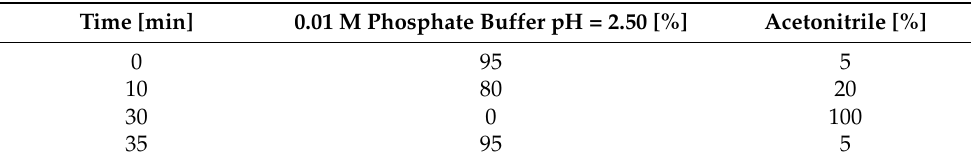
Table 2. The percentage composition of the mobile